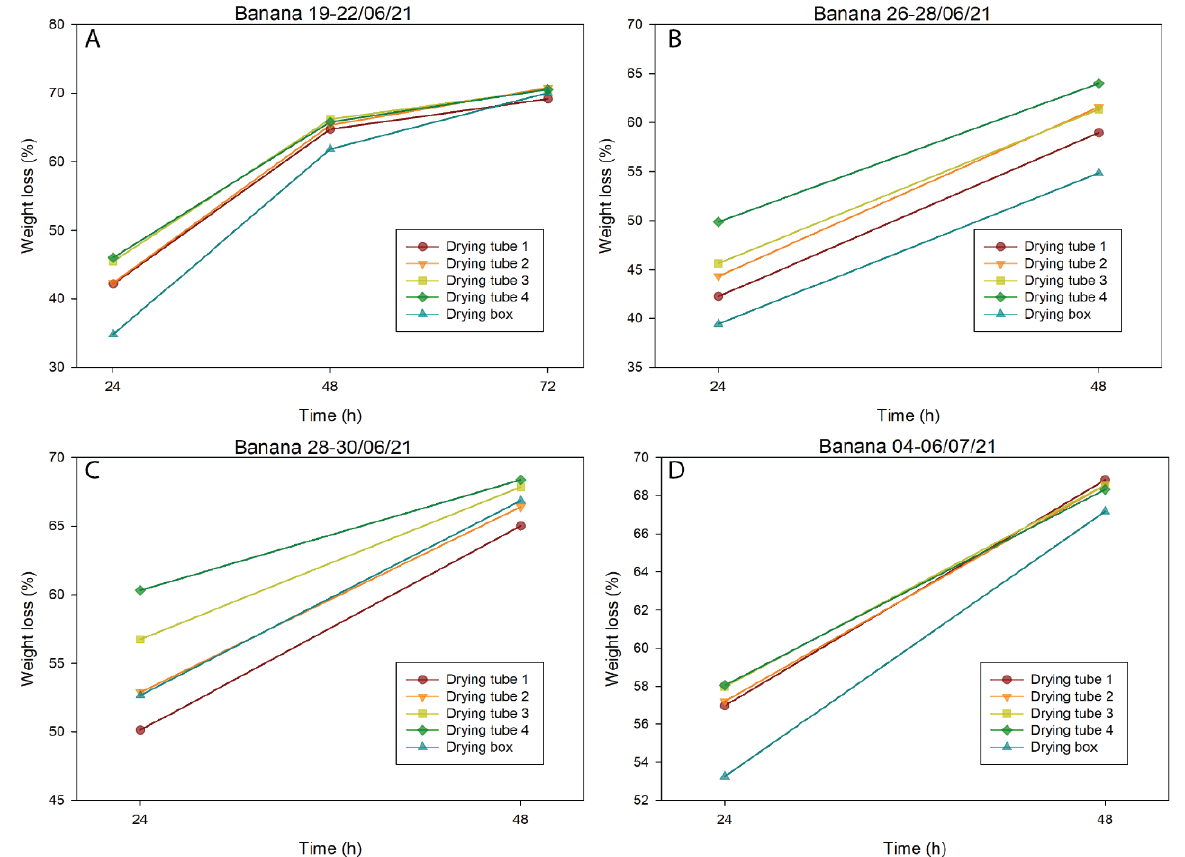
Figure 7. Banana’s daily average weight loss (% of initial fresh weight) for each drying tube and the drying box for the period of ( A ) 19/06–22/06/2021, ( B ) 26/06–28/06/2021, ( C ) 28/06–30/06/2021, and ( D ) 04/07–06/07/2021.